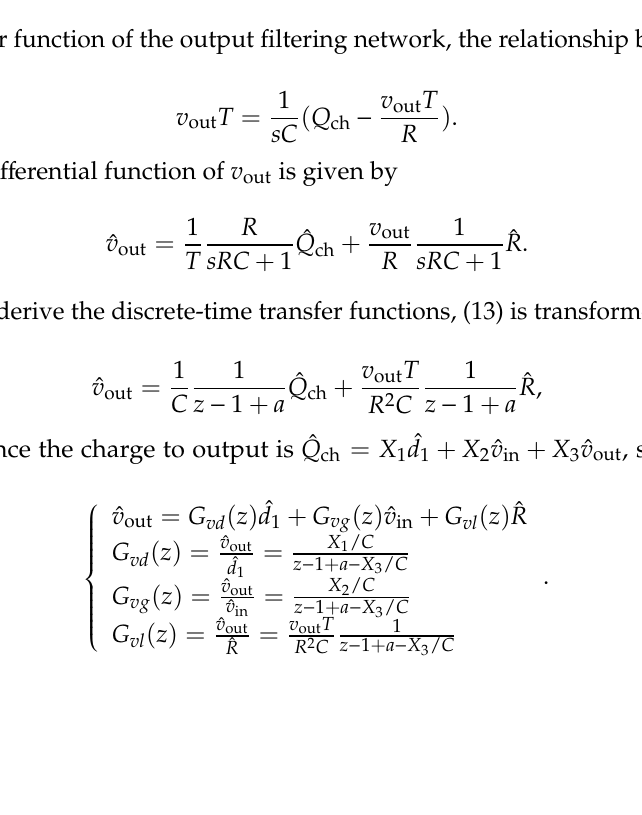
Figure 6. Small signal model of the closed-loop system under LDCB control.